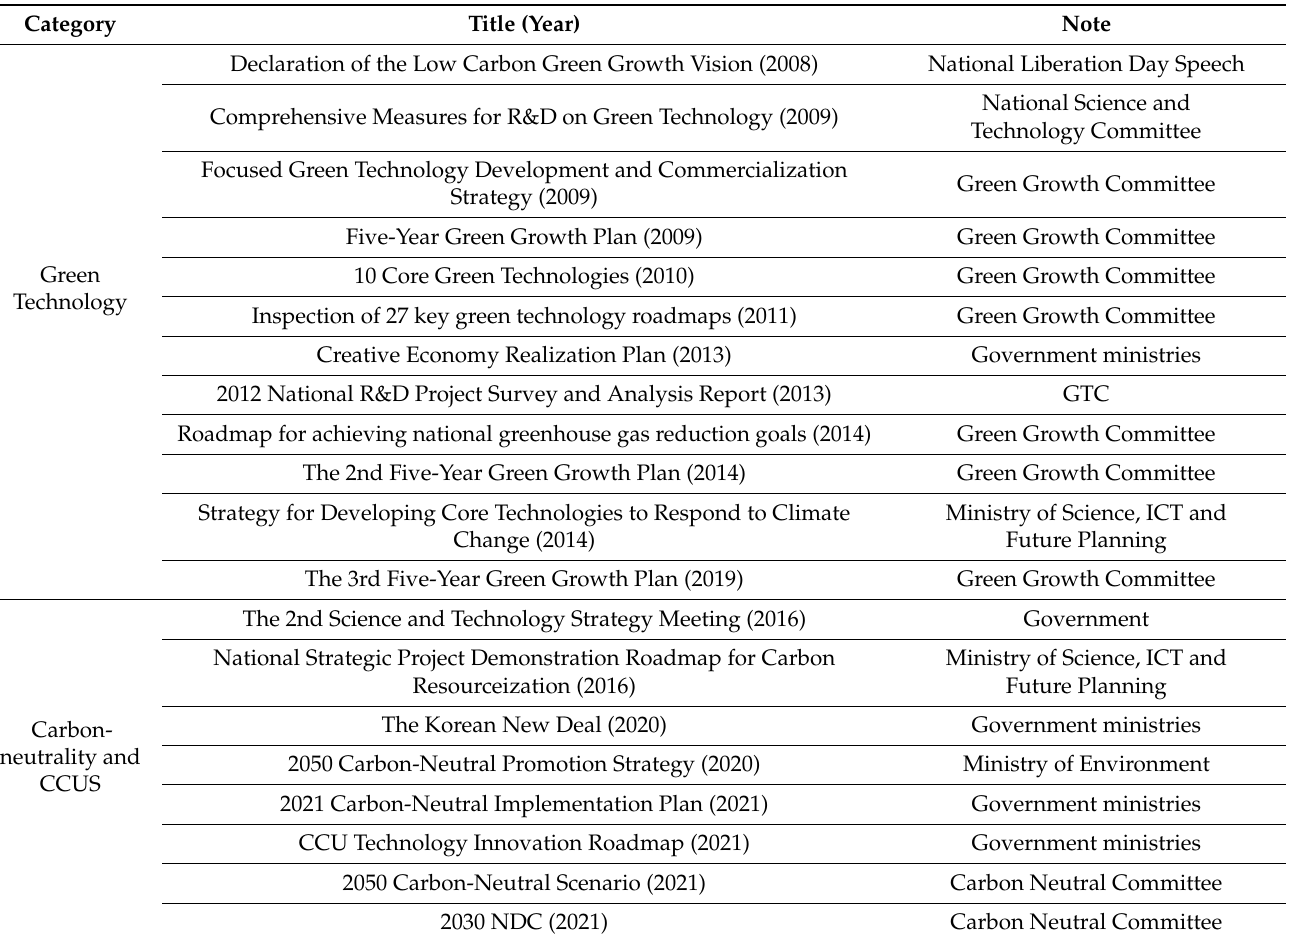
Table 1. Korea’s major policies related to green technology, carbon neutrality, and Carbon Capture Utilization and Storage